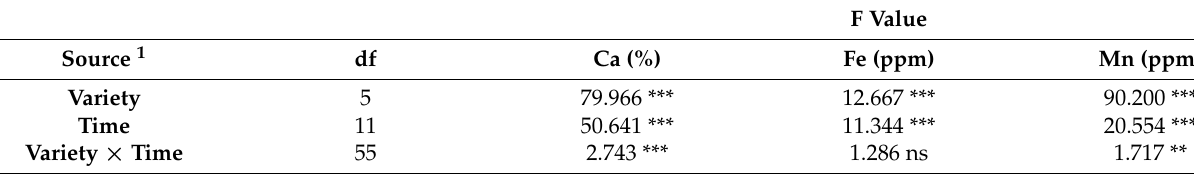
Table 1. Effects of variety, time, and interaction on the calcium, iron, and manganese concentrations in ‘Amfissis’, ‘Chondrolia Chalkidikis’, ‘Kalamon’, ‘Koroneiki’, ‘Mastoidis’, and ‘Picual’. F